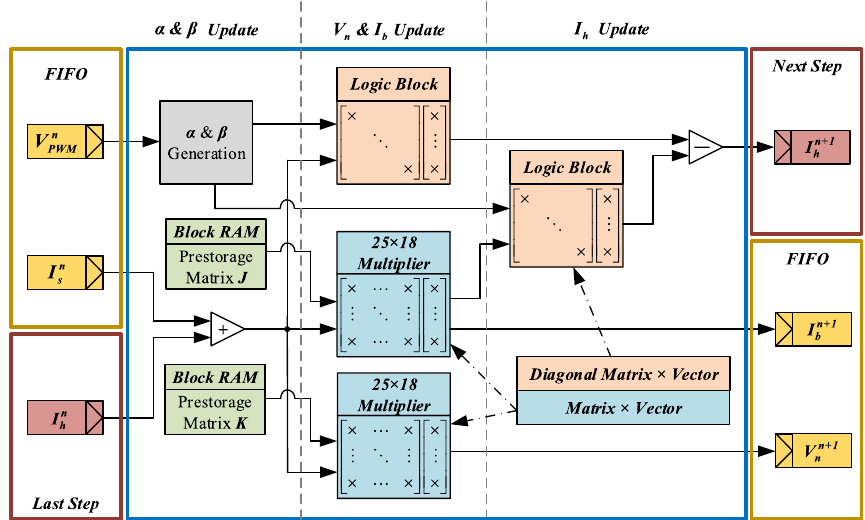
Fig. 7 The FPGA implementation of the C-EMTP